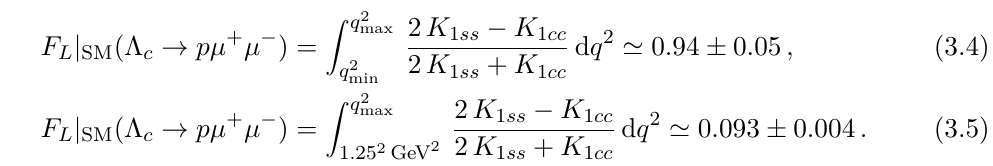
Figure 2 . The fraction of longitudinally polarized dimuons F L (2.12) in the SM. The solid dark line corresponds to the contribution from C 9 The pale bands illustrate a 10% splitting between the longitudinal and the transverse fudge factors, which is forbidden at zero recoil, see text. At both zero and maximum recoil holds F